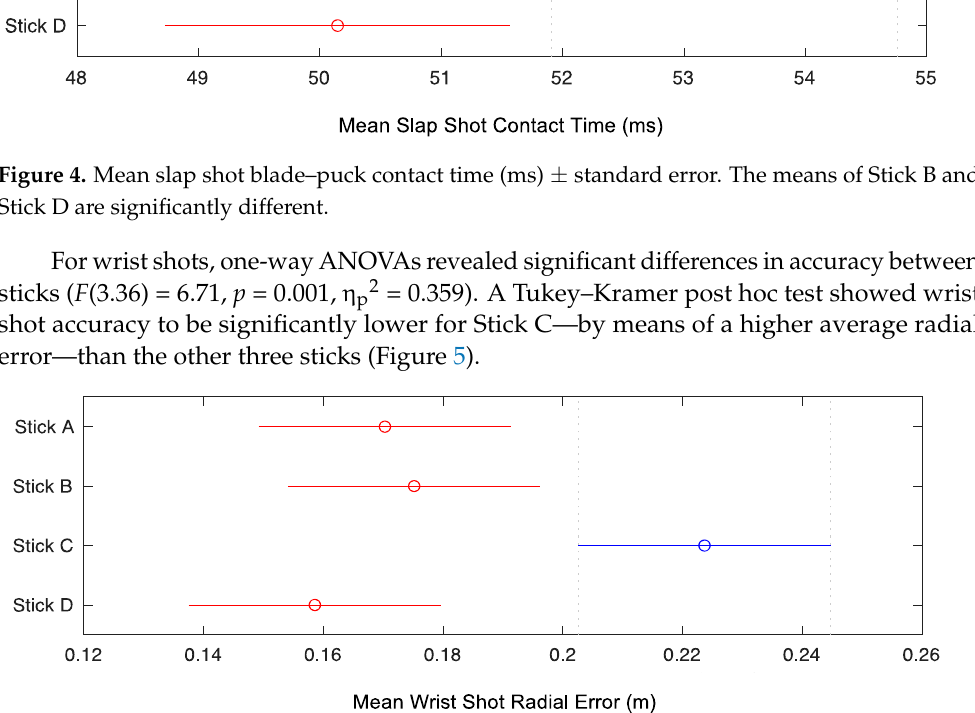
Figure 5. Mean wrist shot radial error from target center (m) ± standard error. The mean of Stick C is significantly different from Sticks A, B, and D.